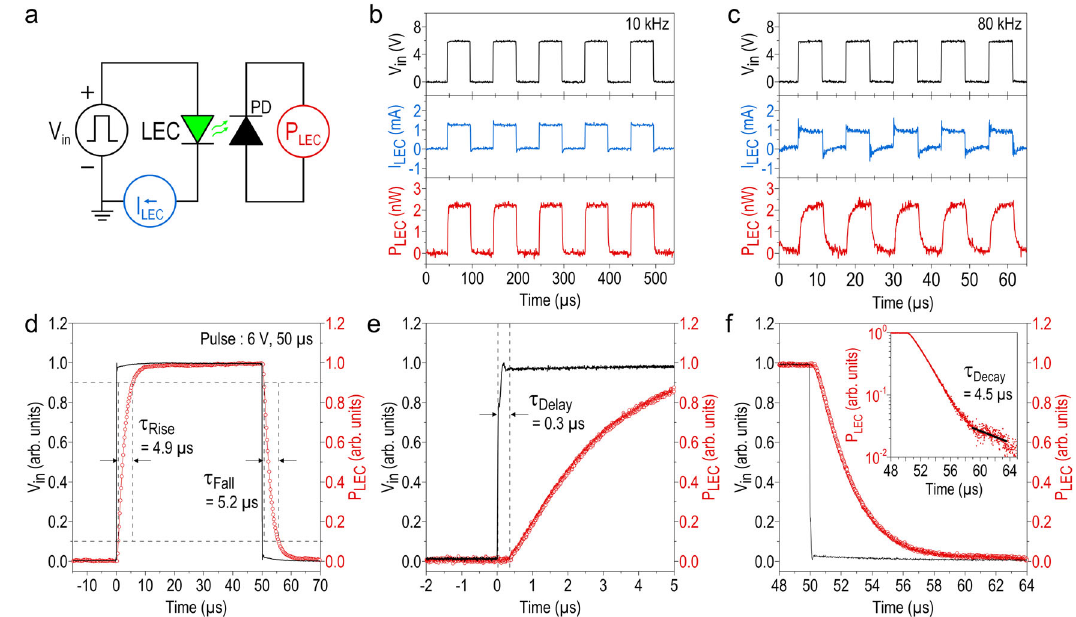
Fig. 3 Transient response of CsPbBr 3 QD-based LEC. a Circuit diagram illustrating the transient measurement setup for simultaneously monitoring the pulse voltage (V in ) applied on the LEC, the electrical current (I LEC ) fl owing through the LEC, and the optical output-power (P LEC ) emitting by the LEC. b , c Time traces of I LEC and P LEC of the LEC under modulated V in at 10 kHz and 80 kHz. d Temporal P LEC in response to a square-wave pulse voltage of V in (magnitude: 6 V, pulse width: 50 μ s, and duty cycle: 50%) applied on the LEC. The rise ( τ Rise ) and fall ( τ Fall ) times of P LEC are also marked in the fi gure. e The enlarged rising edge of P LEC , where τ Delay , the time delay from the turn-on of V in till the onset of P LEC , is estimated to be ~0.3 μ s. f The enlarged falling edge of P LEC with the inset showing the same falling edge but plotted in a semi-logarithmical scale to extract the decay time ( τ Decay ) of the de-trapped